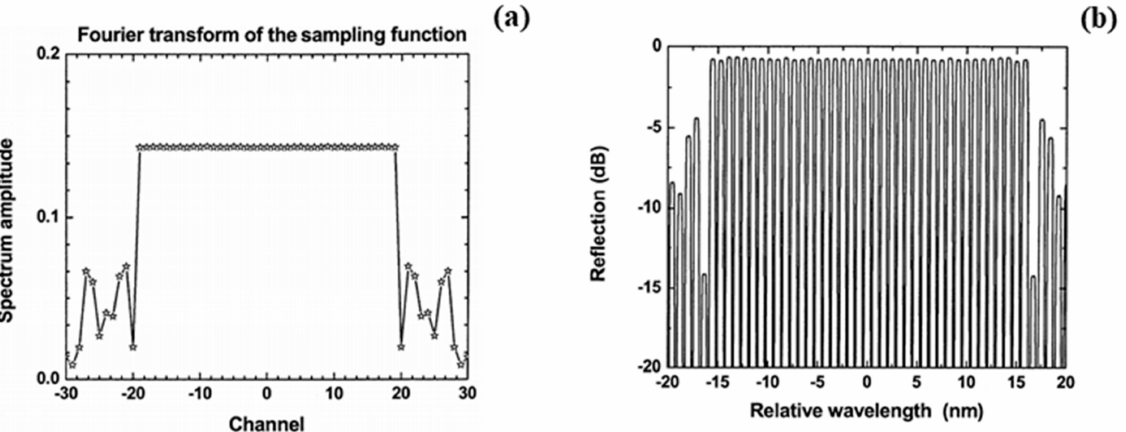
Figure 16. Design results for a binary phase-only sampled FBG. ( a ) Fourier spectrum of the binary phase-only sampling function (one sampling period). ( b ) Reflection spectrum of the 39-channel FBG. Adapted with permission from ref. [107]. © [2022]